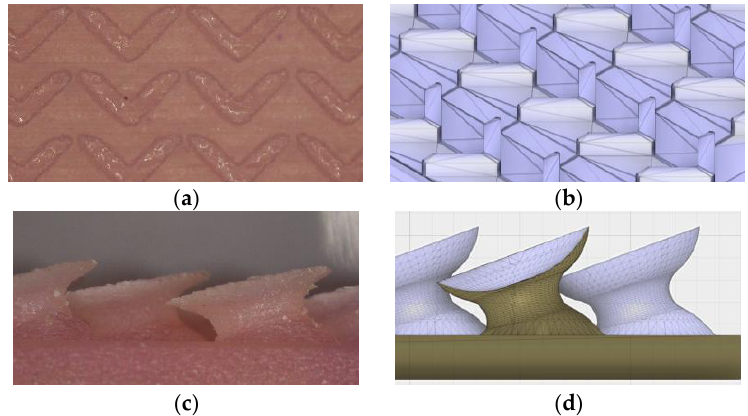
Figure 1. ( a ) Chevron microscopic profile; ( b ) Chevron pattern of the texture constituent; ( c ) Suction pads microscopic profile; ( d ) Suction pads texture cross-section of the constituent.